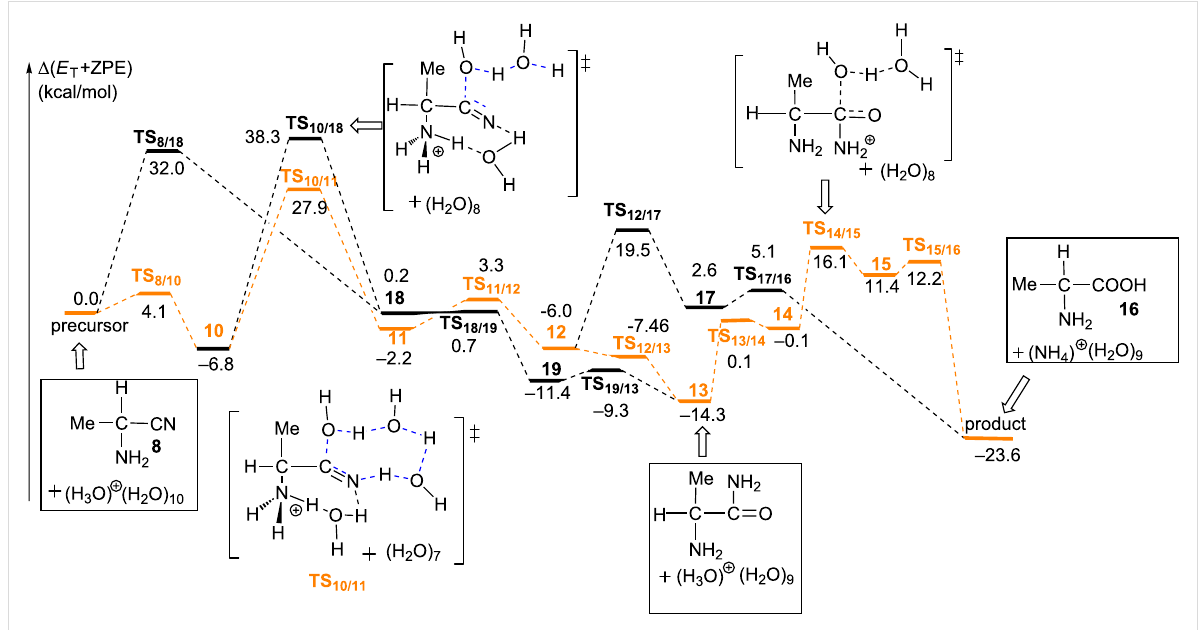
Figure 4: Energy changes along elementary processes from 2-amino nitrile 8 to 2-amino acid 16 . Brown-color lines stand for the most favorable route.